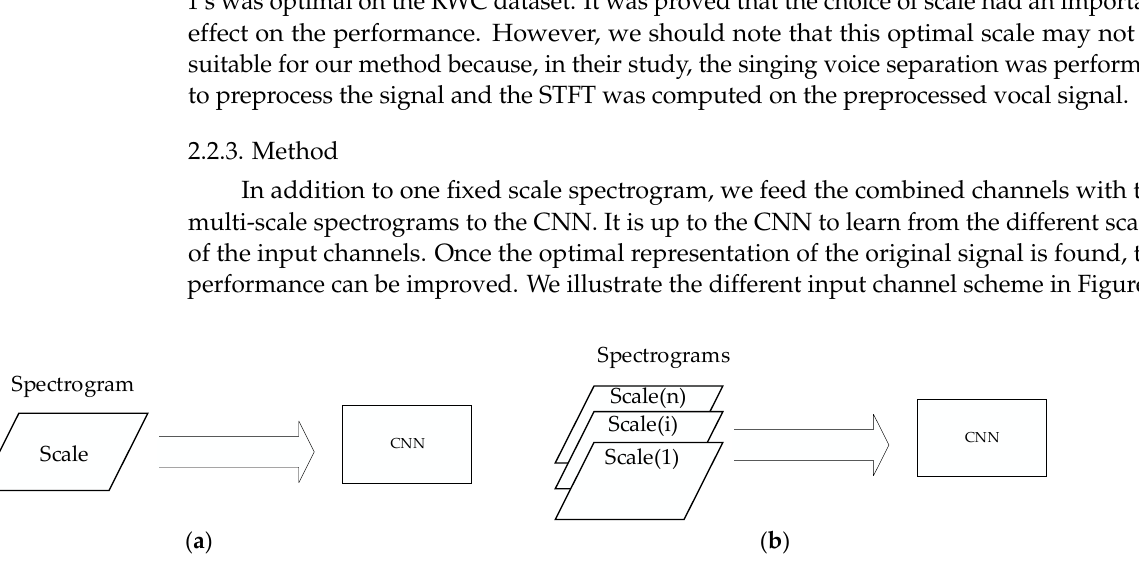
Figure 6. Single scale spectrogram input ( a ) and the multi-scale spectrograms’ input ( b ).